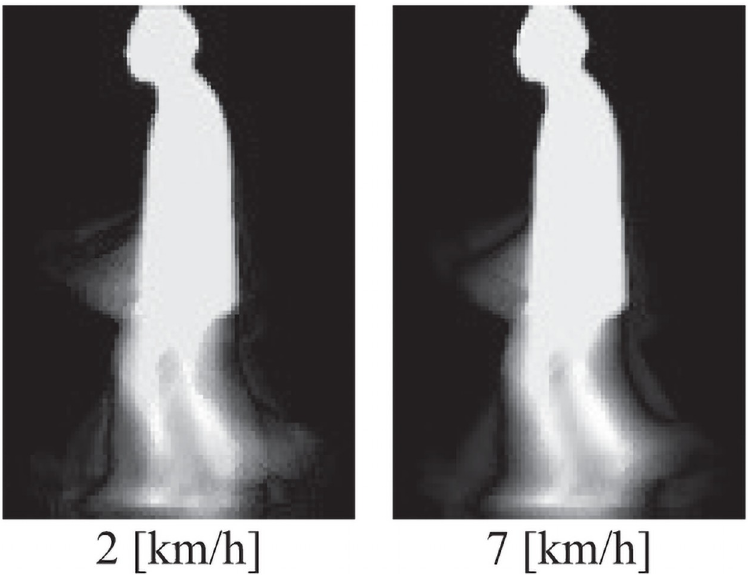
Fig 4. Visualization of two canonical vectors (2 [km/h] and 7 [km/h]) for the 1st canonical angle.